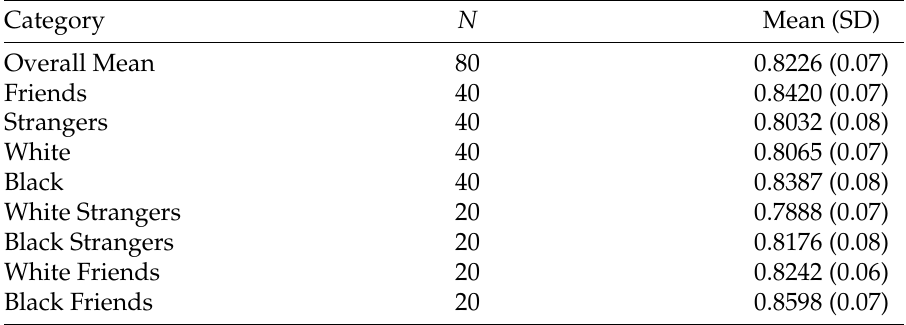
Table 2: Experiment 1 mean role-taking accuracy score Category N Overall Mean